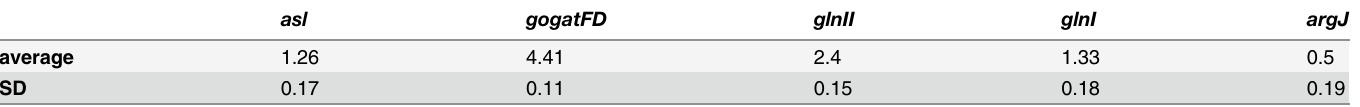
Table 4. Expression of asl , gogat FD, glnII , glnI and argJ in D . glomerata nodules using relative quantitation of the Comparative CT Method (ABI Prism user bulletin #2).